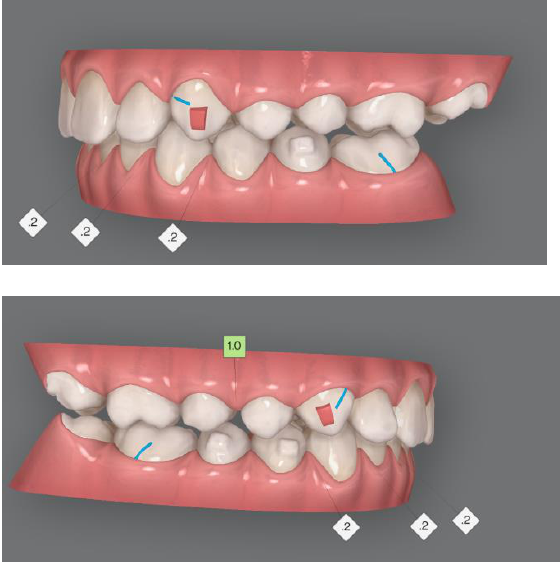
Figure 3. Treatment plan phase II.